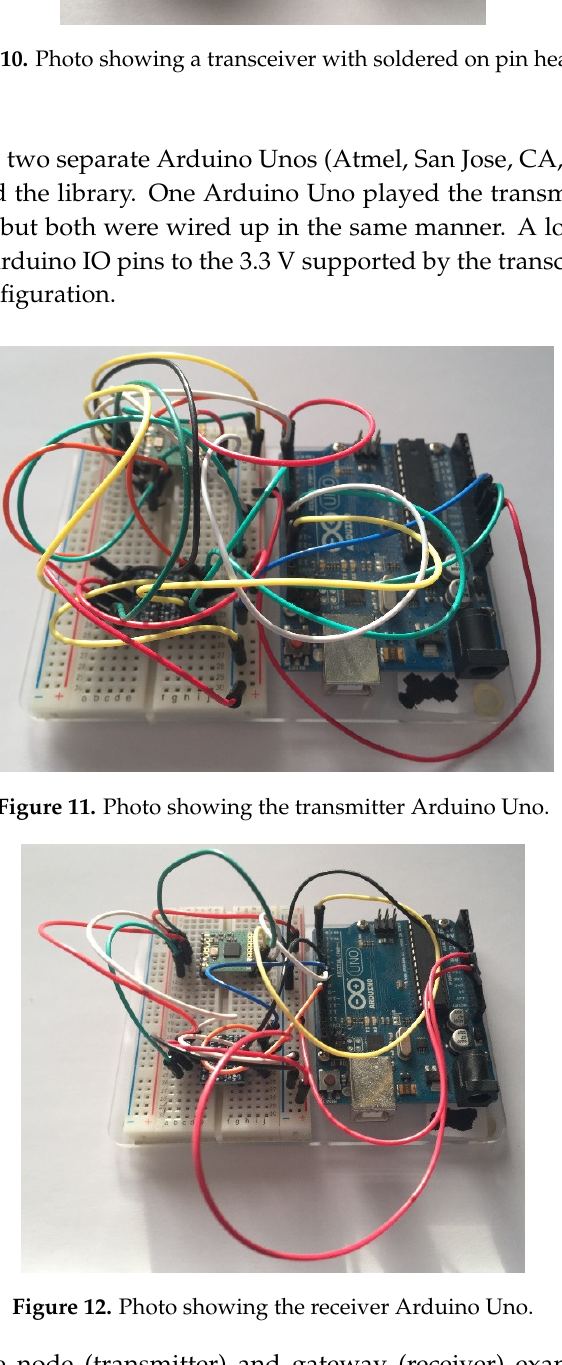
Figure 10. Photo showing a transceiver with soldered on pin headers.